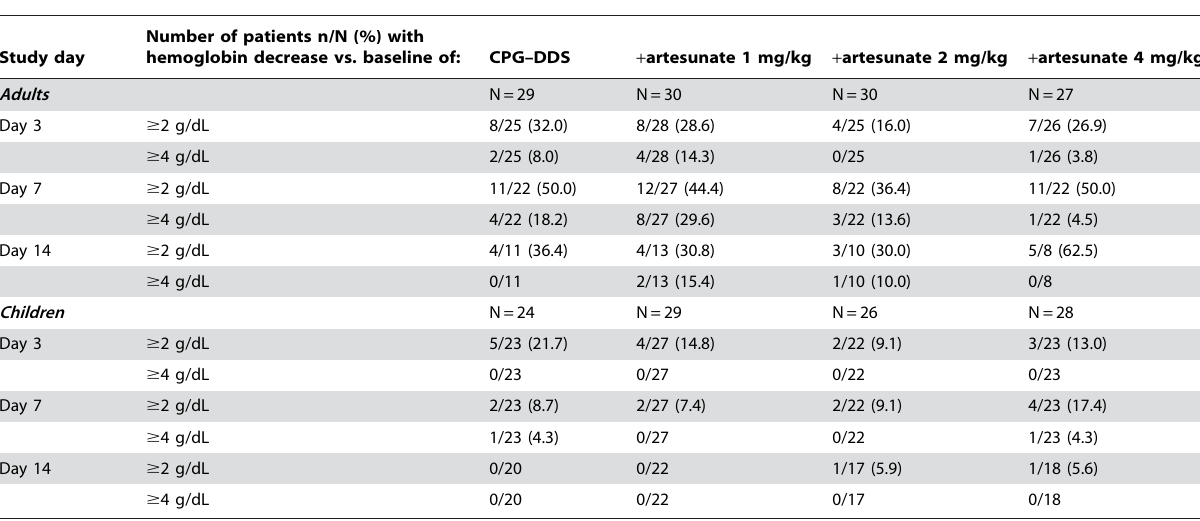
Table 7. Number of patients with a decrease in hemoglobin of $ 2 and $ 4 g/dL from baseline for adults and children in the intent to treat (safety)